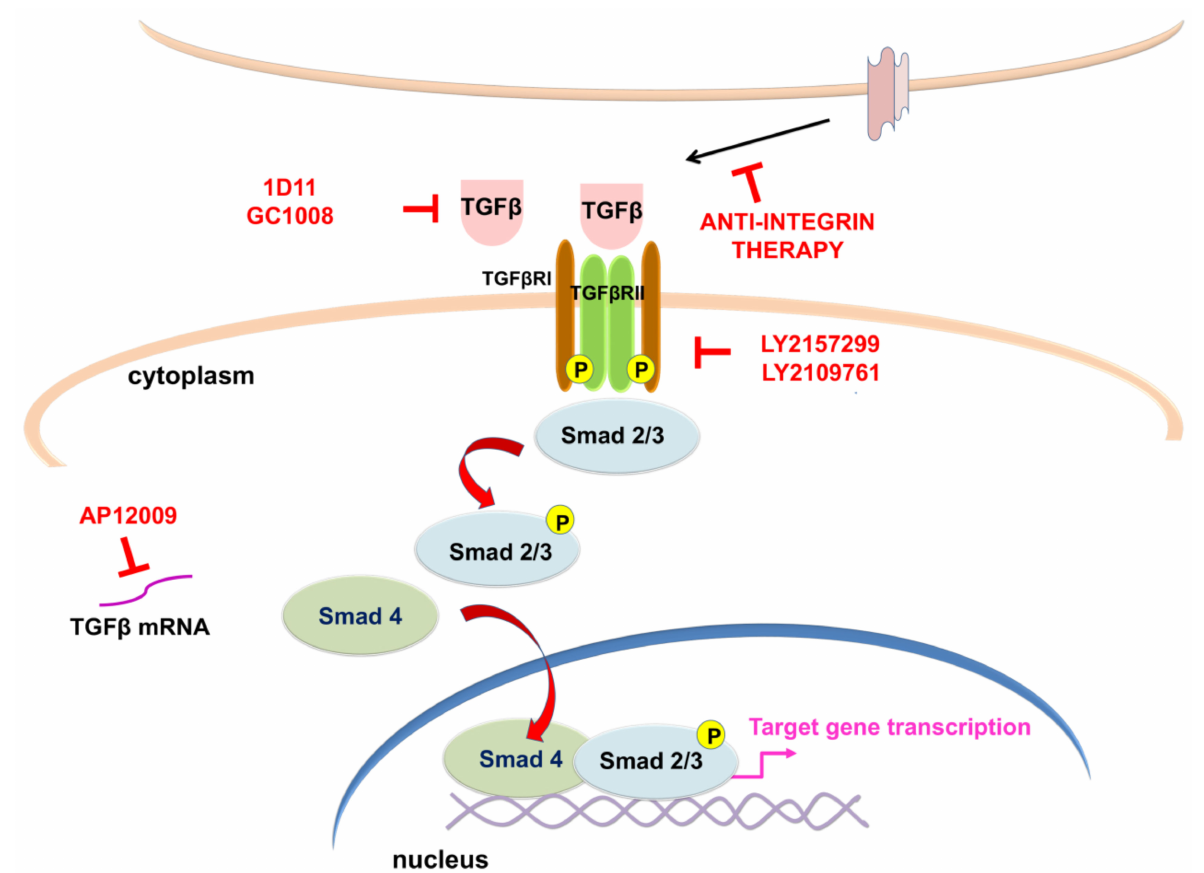
Figure 5. Schematic representation of the canonical (Smad-dependent) TGF β pathway and TGF β signaling therapies which have undergone clinical trials in GBM. TGF β binding to TGF β receptors II (TGF β RII) results in phosphorylation and activation of TGF β receptors I (TGF β RI), phosphorylation of Smad 2/3, which interact with Smad 4 and form a complex that translocates into the nucleus to activate target genes. Antisense oligonucleotides (AP12009), anti-integrins, kinase inhibitors (LY2157299, LY2109761) or neutralizing antibodies (1D11, GC1008) used for targeting TGF β signaling pathway are presented in red. Based on [274] and references included in the main